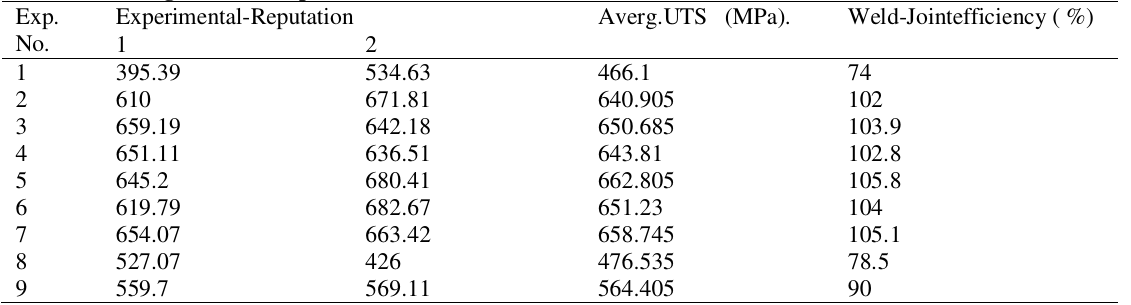
Results of average for nine experimental 012 tests of this work